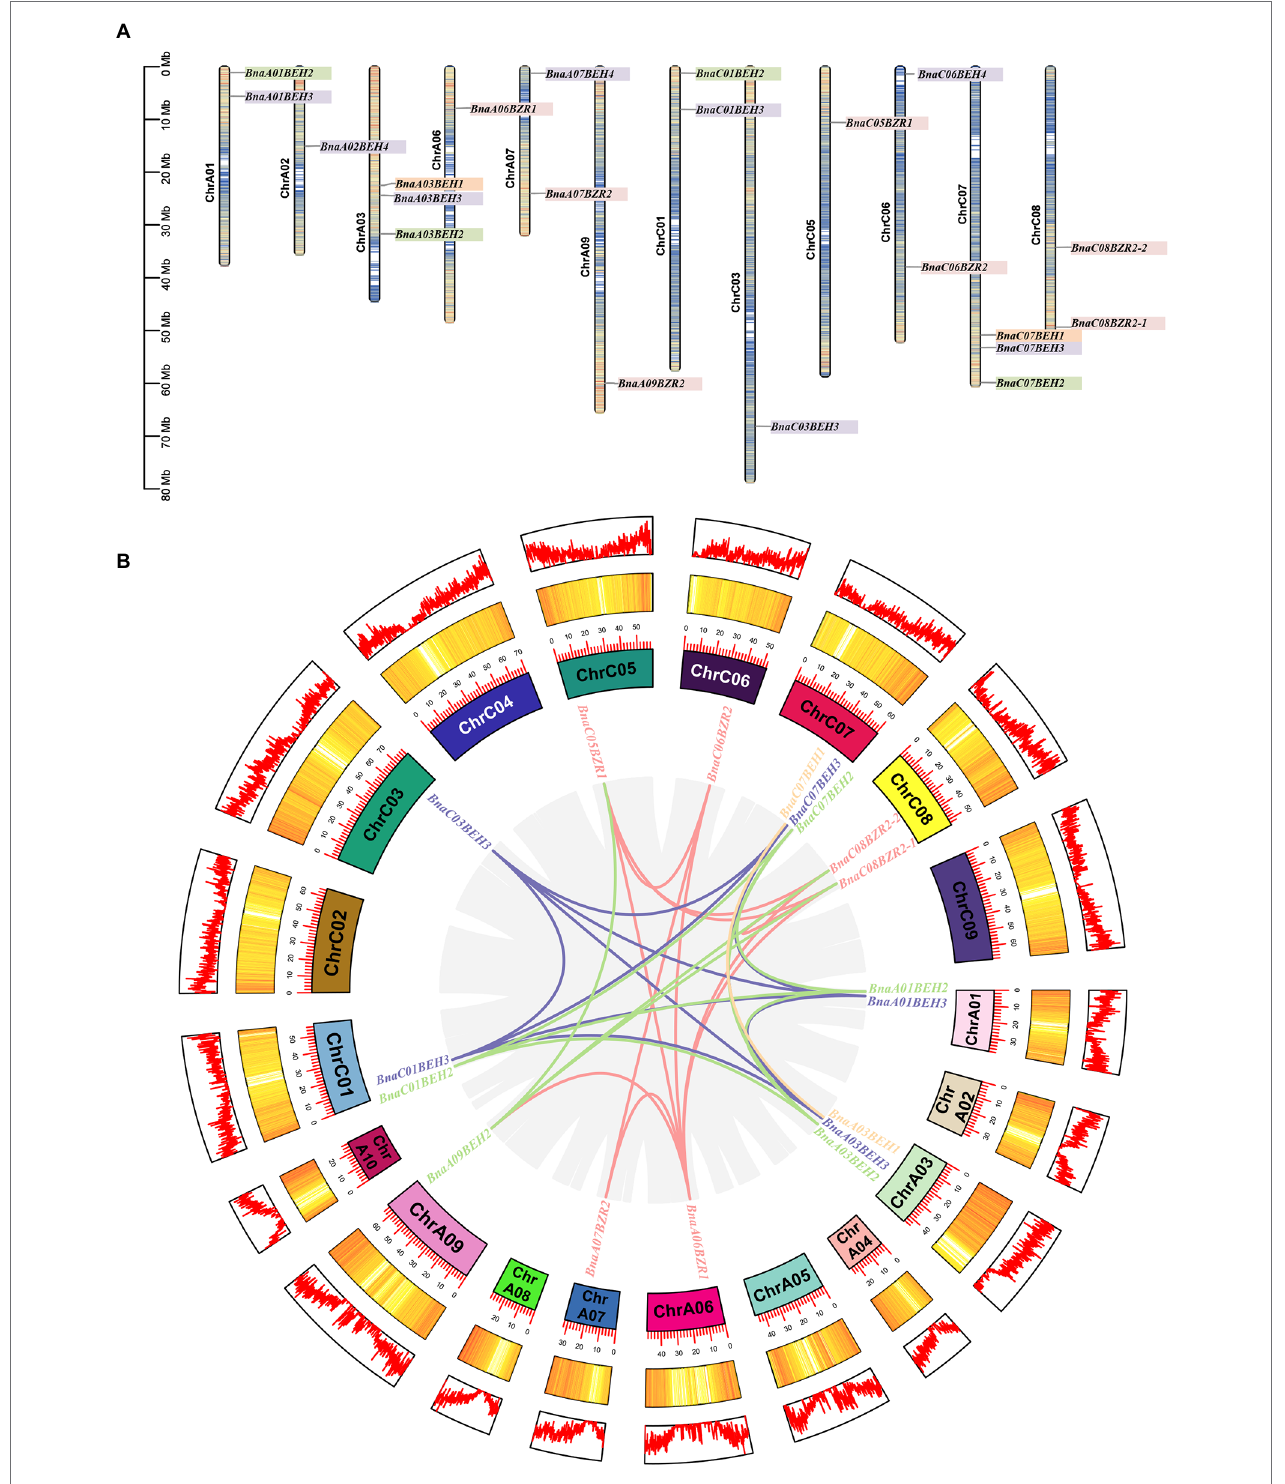
FIGURE 5 | Chromosomal location and genome duplication of BnaBZRs. (A) Distribution of BnaBZRs on B. napus chromosomes. Genes from the same group are indicated by the same highlighted color. (B) Synteny analysis of BnaBZRs in B. napus. Lines with same color belong to the same BnaBZR gene subfamily indicate segmental duplication in B. napus chromosomes. Gray lines in the background indicated as B. napus genome synteny blocks. Number of each B. napus chromosome is represented as different colored box with the scale size is in Kb, and the outer circle represents the gene density profile of each